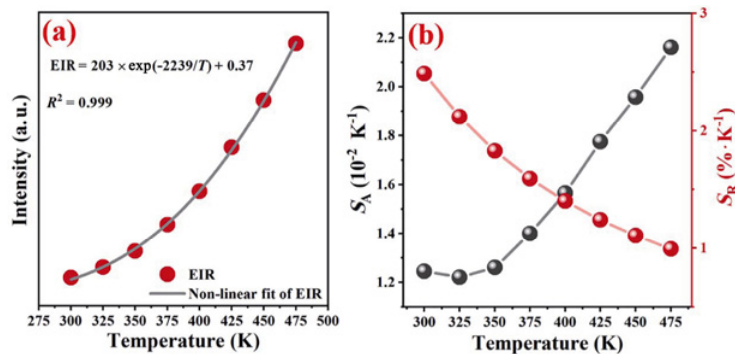
Fig. 9 (a) Variation of EIR. (b) Changes of S A and S R in response to temperature.